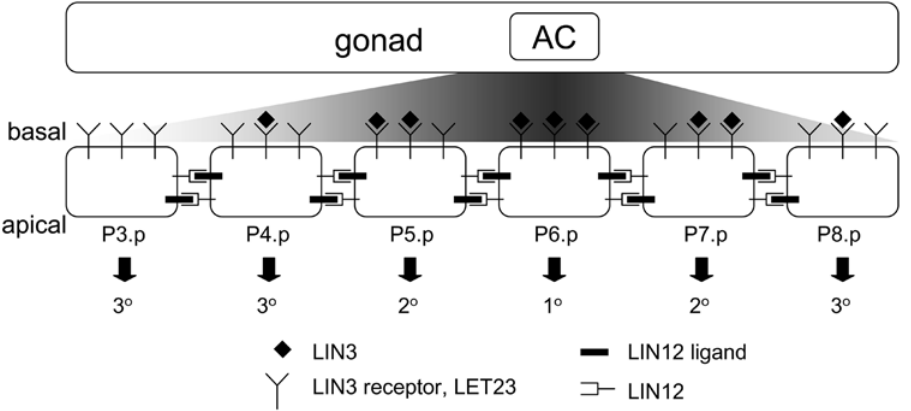
Figure 1. Wild-type patterning of C.elegans vulva. The anchor cell (AC) stimulates the vulva precursor cells Pn.p with LIN-3 in a graded manner. These cells laterally interact with their neighbors through the LIN-12 pathway. The crosstalk between LIN-3 and LIN-12 signaling results in the wild- type pattern of differentiation 3 u 3 u 2 u 1 u 2 u 3 u . In the wild-type organism, the 1 u vulval lineage generates progeny that forms the orifice and connects to the uterus, while the 2 u vulval lineage generates progeny that form the vulval lips and connect to the body epidermis. The daughters of the 3 u cells fuse to the surrounding syncytium and do not contribute to the vulval tissue.